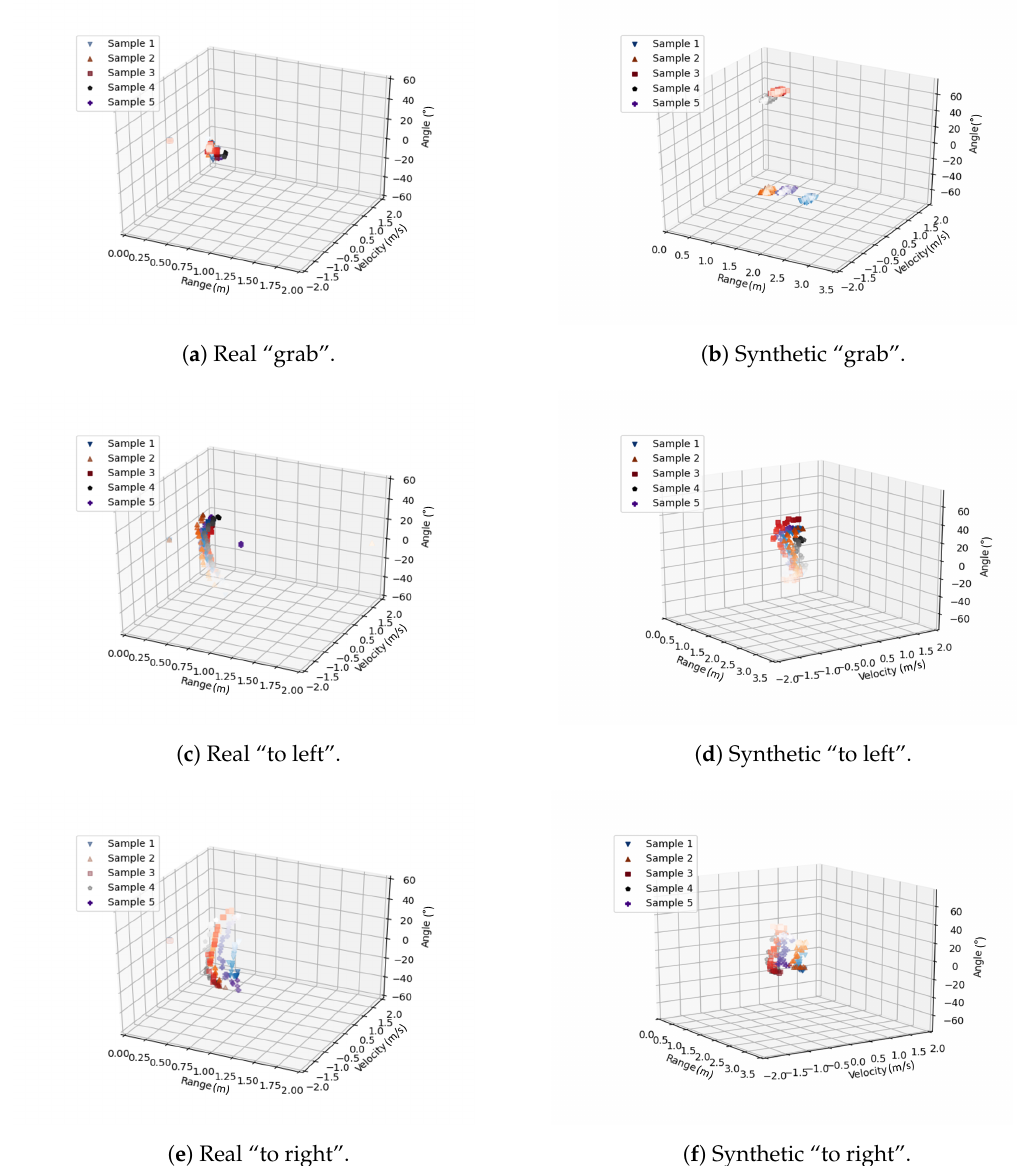
Figure 9. Comparison of “grab”, “to left” and “to